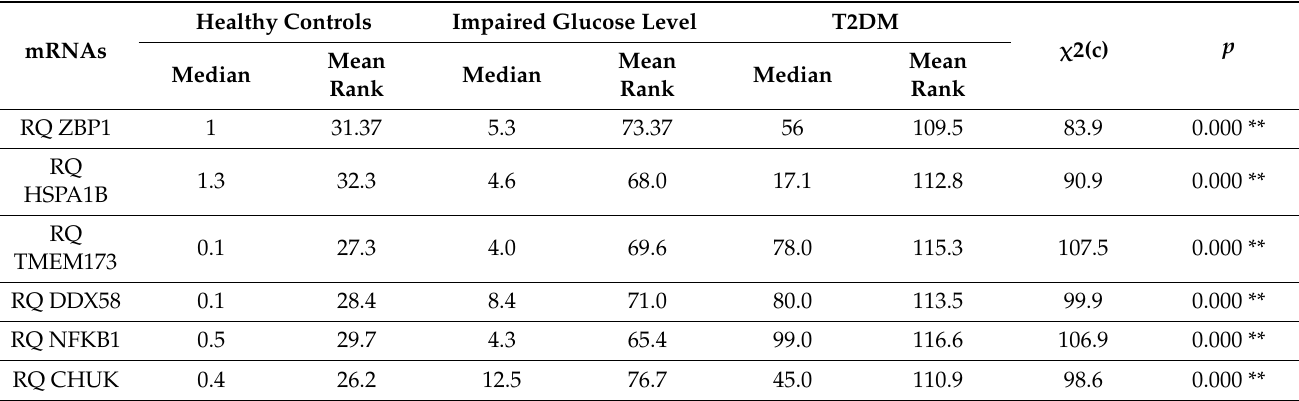
Table 1. The relative expression of the ZBP1, HSPA1B, TMEM173, DDX58, NFKB1 and CHUK mRNAs among all the studied groups.